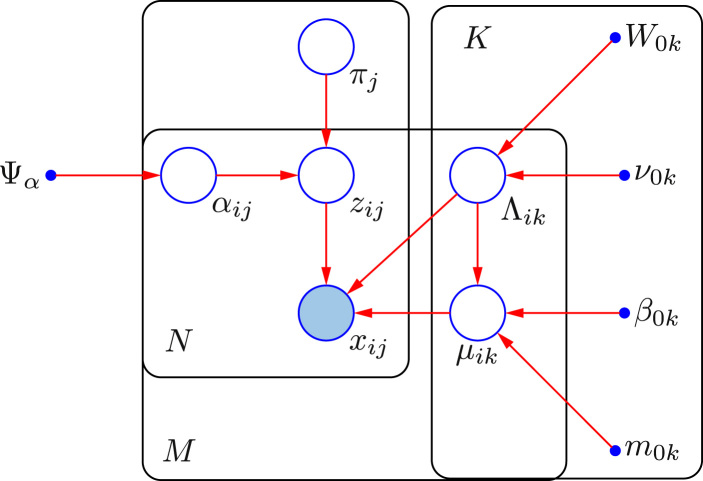
Directed acyclic graph representing the Gaussian mixture model that the VBEM method relies on.